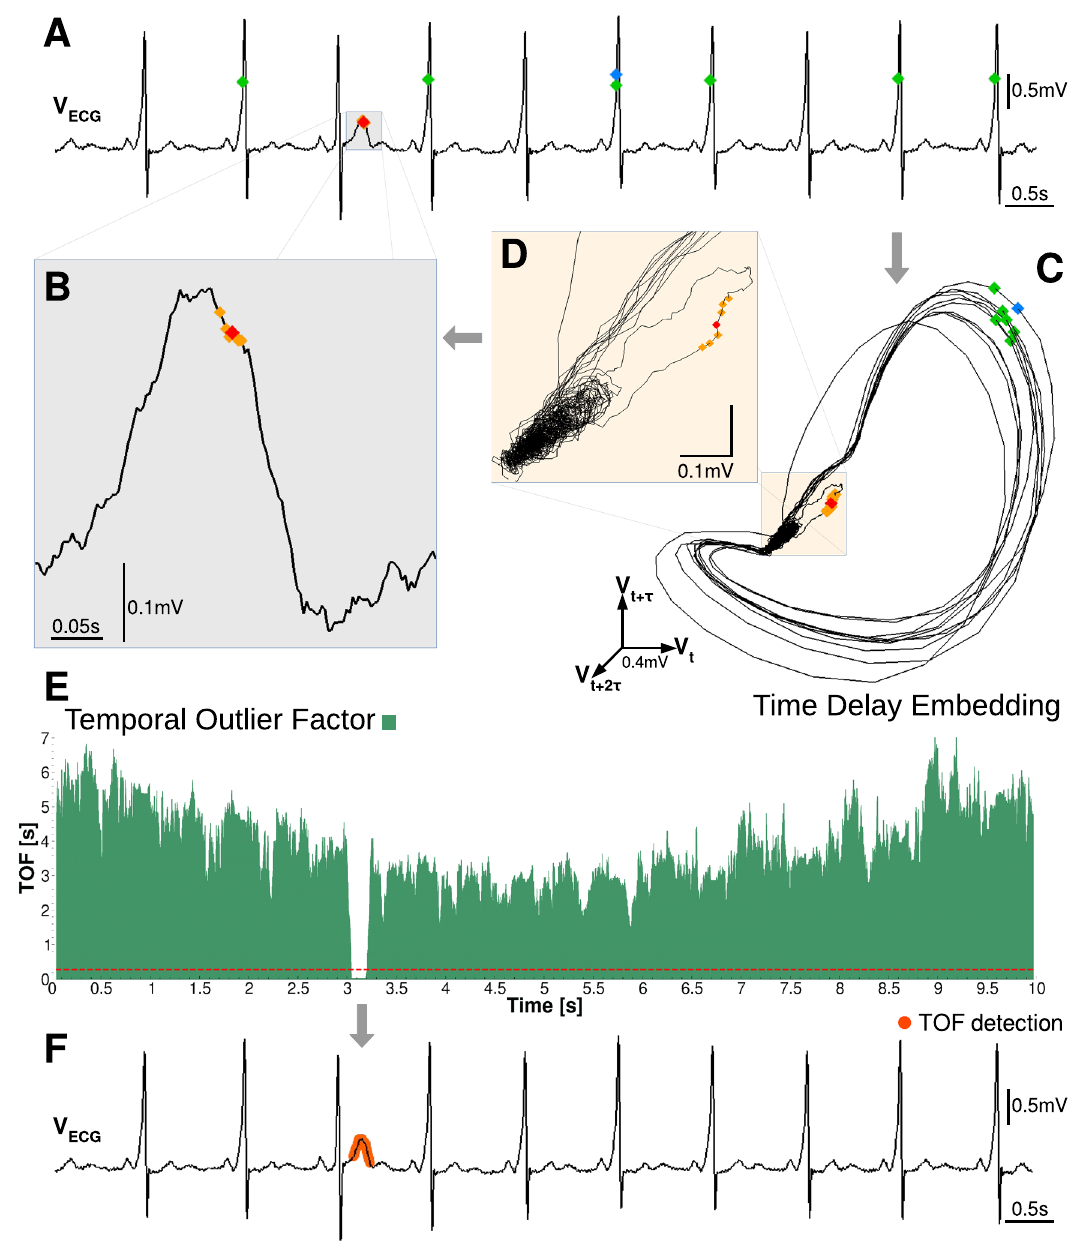
Figure 1. Schema of our unique event detection method and the Temporal Outlier Factor (TOF). ( A ) An ECG time series from a patient with Wolff-Parkinson-White Syndrome, a strange and unique T wave zoomed on graph ( B ). ( C ) The reconstructed attractor in the 3D state space by time delay embedding ( E = 3, τ = 0.011 s ). Two example states (red and blue diamonds) and their 6 nearest neighbors in the state space (orange and green diamonds respectively) are shown. The system returned several times back to the close vicinity of the blue state, thus the green diamonds are evenly distributed in time, on graph ( A ). In contrast, the orange state- space neighbors of the red point (zoomed on graph D ) are close to the red point in time as well on graph ( A ). These low temporal distances show that the red point marks a unique event. ( E ) TOF measures the temporal dispersion of the k nearest state-space neighbors ( k = 20 ). The red dashed line is the threshold θ = 0.28s . Low values of TOF below the threshold mark the unique events, denoted by orange dots on the original ECG data on graph ( F